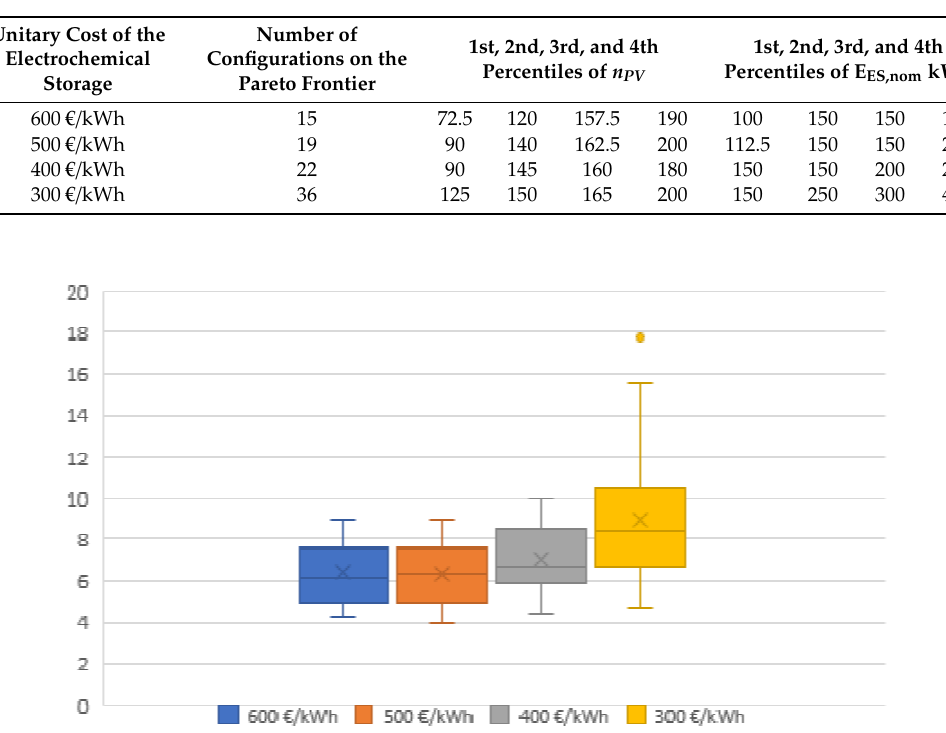
Figure 21. Box and whisker plot of the median value of the electrochemical storage 𝑆𝑜𝐶 (cid:3006)(cid:3020) , depending on the ES unitary cost. 6. Conclusions In this work, we optimized a HRES system serving a reference off-grid small-to-medium accommodation facility, according to a multi-objective perspective: the minimization of No-RES energy consumption and maximization of NPV at the end of system lifetime. After describing both energy and economic models, we showed how the multi-variable optimization problem can be simplified through a correlation analysis of a random sample of possible configurations, to identify the design variables that mainly affect the objective functions. The methodology has been applied to a test case including air-to-water heat pumps, a combined